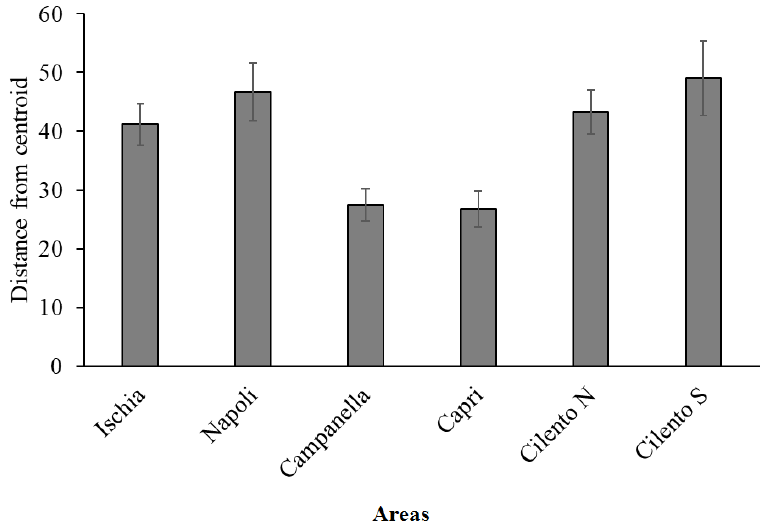
Figure 5. Mean (± SE) multivariate dispersion (PERMDISP) of replicates around areas centroids, calculated on CSS densities. High distances correspond to high heterogeneity and consequently high β-diversity in each area.